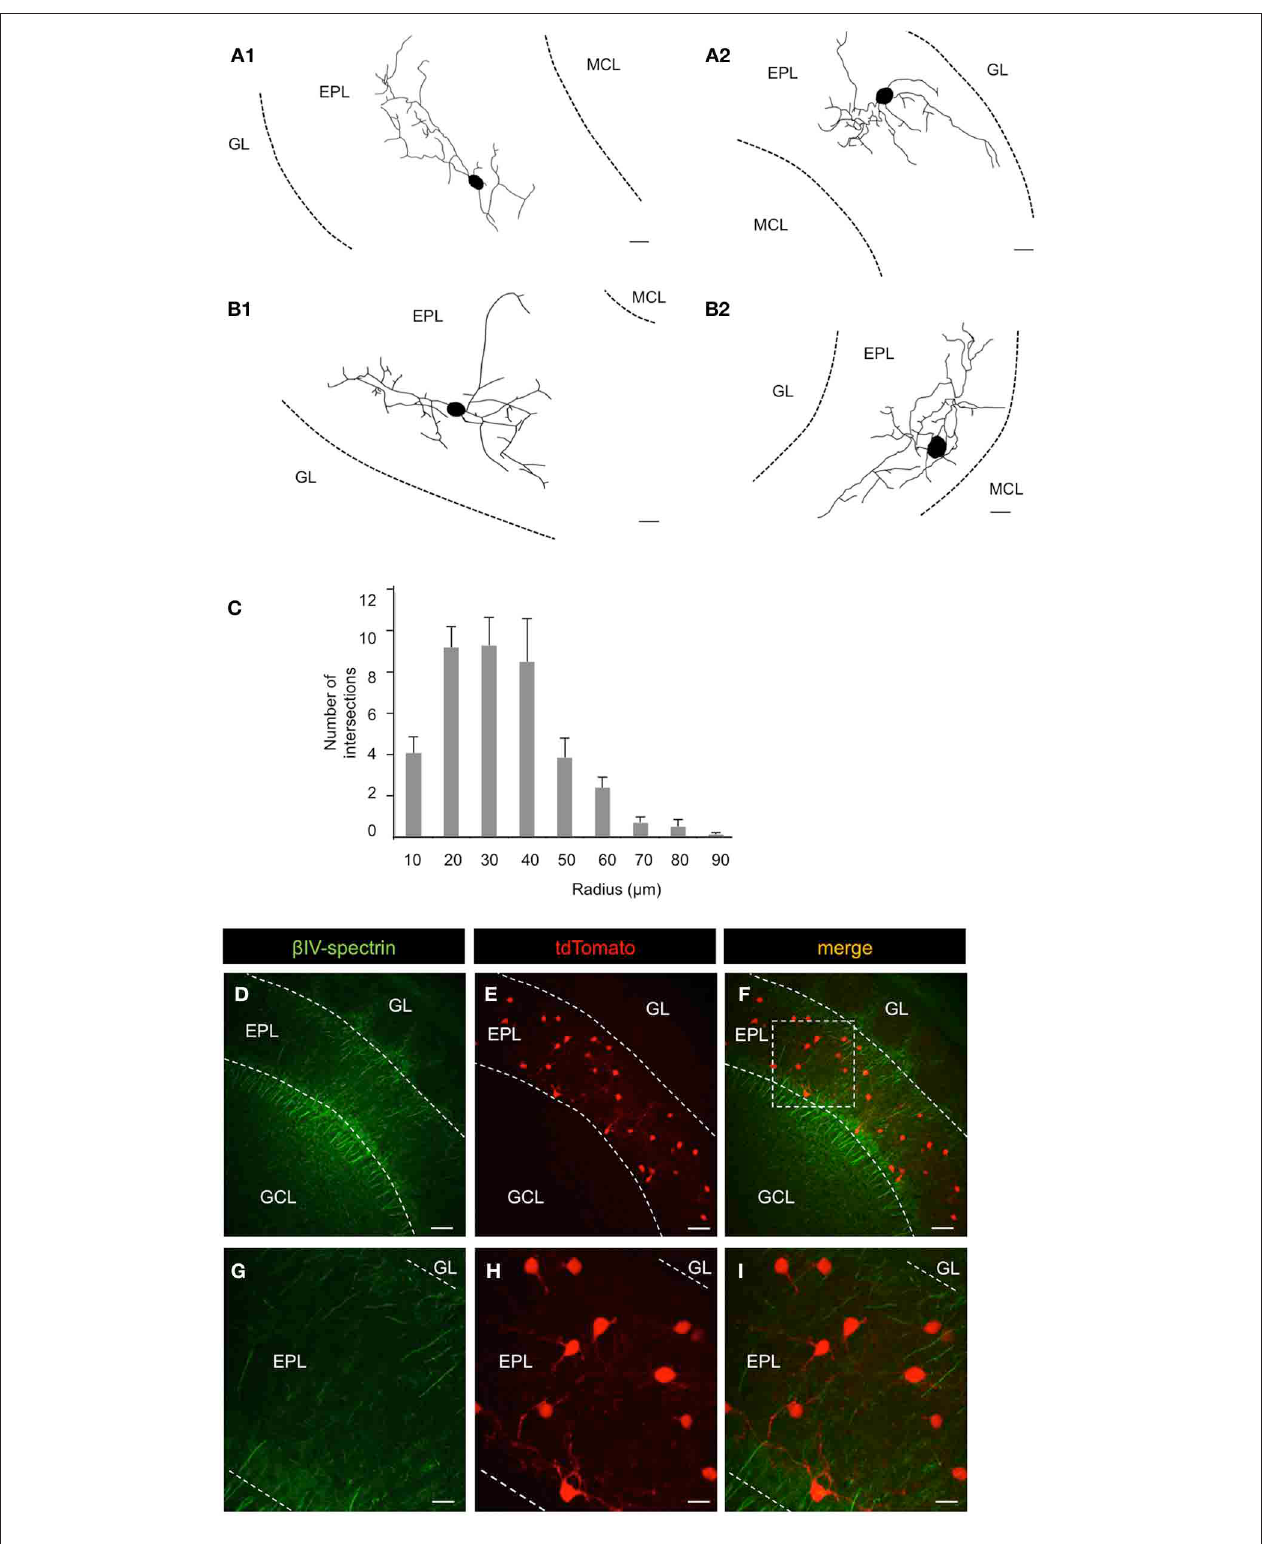
FIGURE 3 | Morphological and electrical properties of EPL interneurons in the MOB. (A1) and (A2) Reconstruction of CRH + EPL interneurons labeled via biocytin fill. Scale bar, 10 μ m. (B1) and (B2) Reconstruction of CRH + EPL interneurons labeled via AAV (flexed ChR2) injection into a CRH-Cre mouse. Scale bar, 10 μ m. (C) Sholl analysis of CRH + EPL